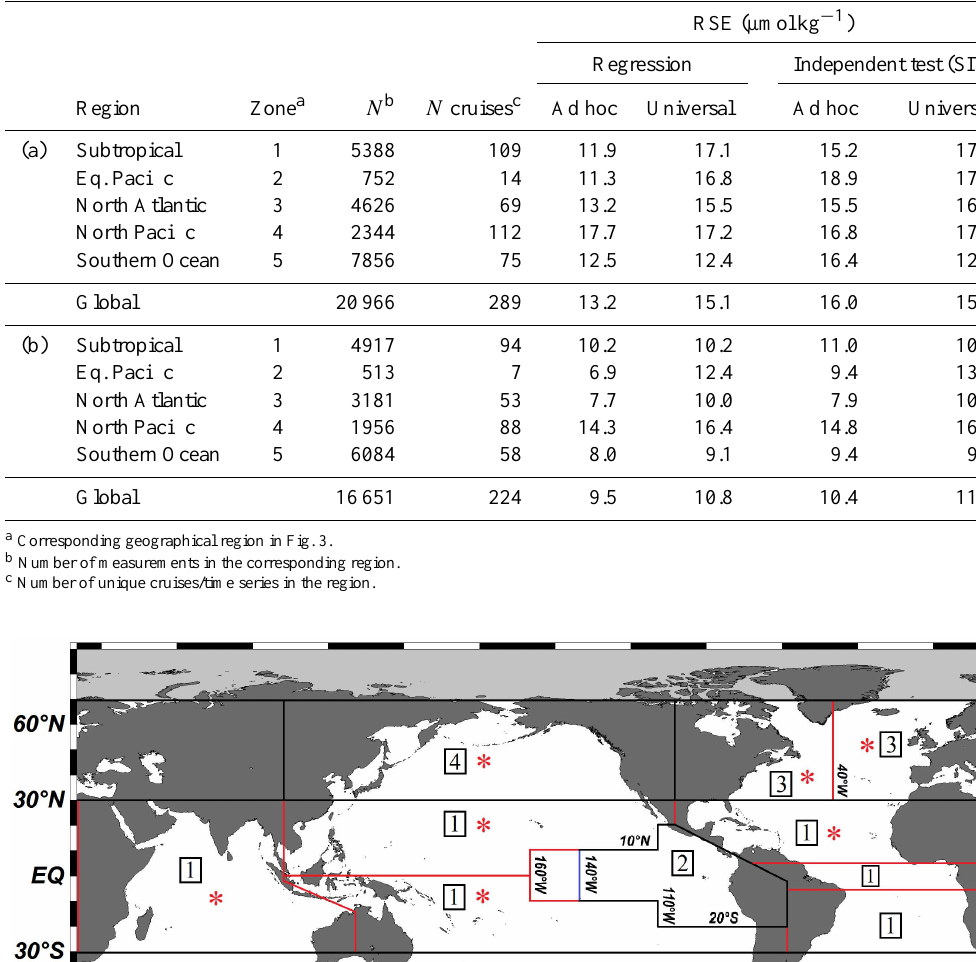
Table 3. Universal and ad hoc MLR results for (a) C T and (b) A T .